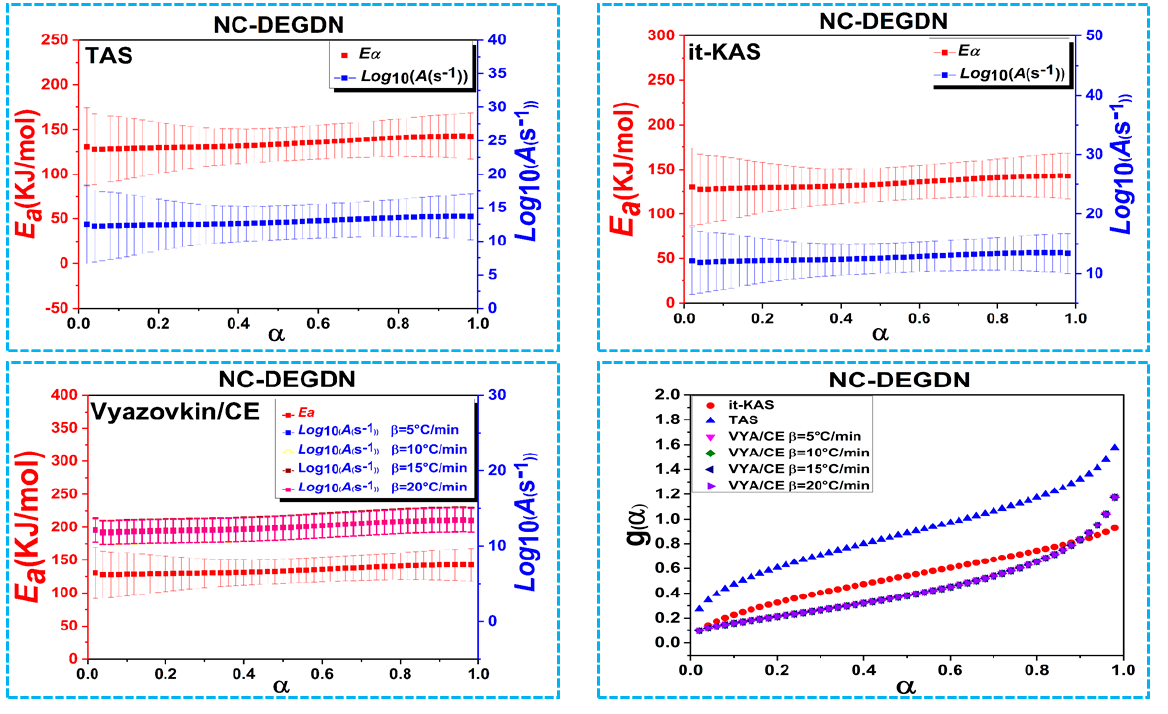
Figure 4. Variation of the kinetic parameters versus conversion for the thermal decomposition of NC-DEGDN composite.